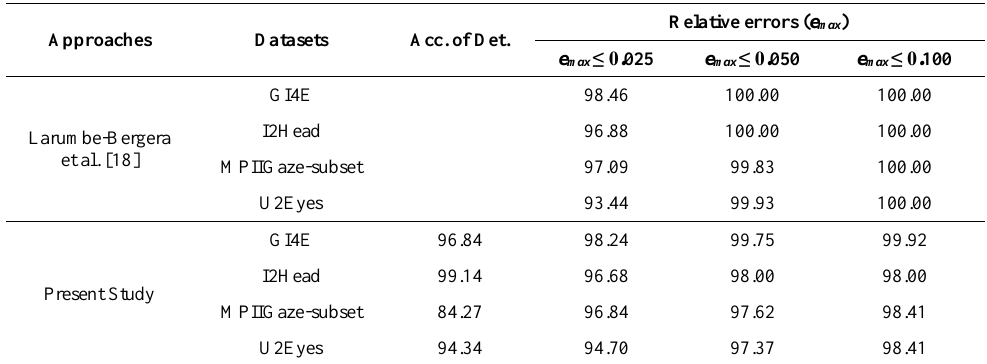
Table 4. Accuracies of detection (Acc. of det.) and relative errors for pupil center location on GI4E, I2HEAD, MPIIGaze